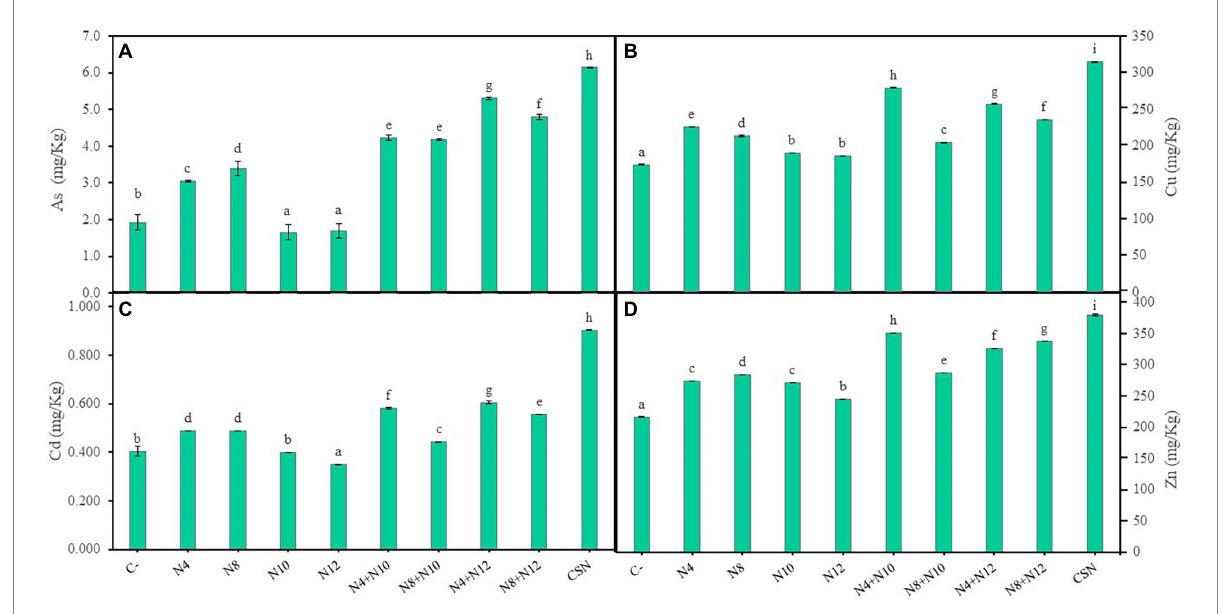
FIGURE 6 Accumulation of metal/loids in roots of M. sativa . (A) Accumulation of arsenic, (B) copper, (C) cadmium, and (D) zinc after 60 days in pots containing soil from the high marshes of the Odiel River. Values are means ± S.D. ( n = 16). Different letters indicate statistical differences between means (One-way ANOVA; LSD test, p < 0.001). C-: non inoculation; N4: inoculation with Pseudomonas sp. N4; N8: inoculation with Pseudomonas sp. N8; N10: inoculation with Ensifer sp. N10; N12: inoculation with Ensifer sp. N12; N4 + N10: co-inoculation with Pseudomonas sp. N4 and Ensifer sp. N10; N8 + N10: co-inoculation with Pseudomonas sp. N8 and Ensifer sp. N10; N4 + N12: co-inoculation with Pseudomonas sp. N4 and Ensifer sp. N12; N8 + N12: co-inoculation with Pseudomonas sp. N8 and Ensifer sp. N12; CSN: inoculation with Pseudomonas sp. N4, Pseudomonas sp. N8, Ensifer sp. N10 and Ensifer sp.